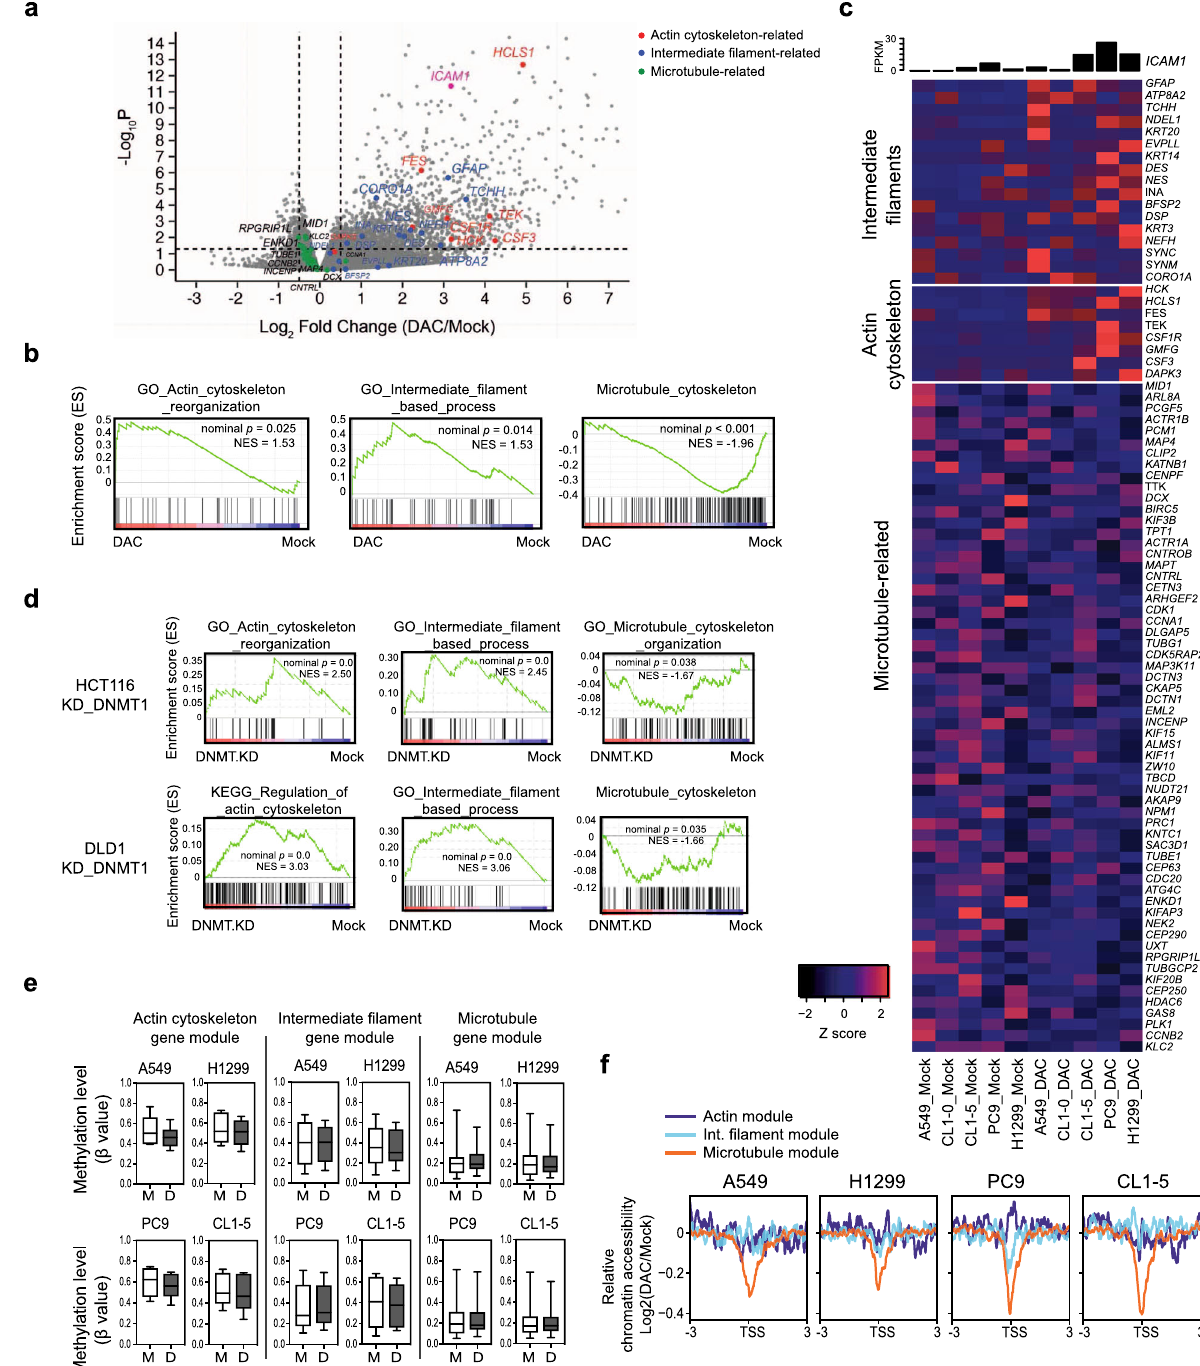
Discussion DNA methyltransferase inhibitors are versatile immunomodu- lators 8,48 , aside from their antitumor effects 49 . These drugs not only may enhance the immunogenicity of cancer cells 9,12,50,51 but have also been shown to modulate αβ T cell fate decisions, dif- ferentiation, and exhaustion 52,53 . Despite the proposed poten- tiating effects of DNMTis on checkpoint inhibitors 8 , the requirement for tumors with high mutational load to trigger conventional αβ TCR-driven, MHC-restricted immune responses limits the added therapeutic bene fi ts of this approach 54 . On the other hand, clinical interest on cell-based